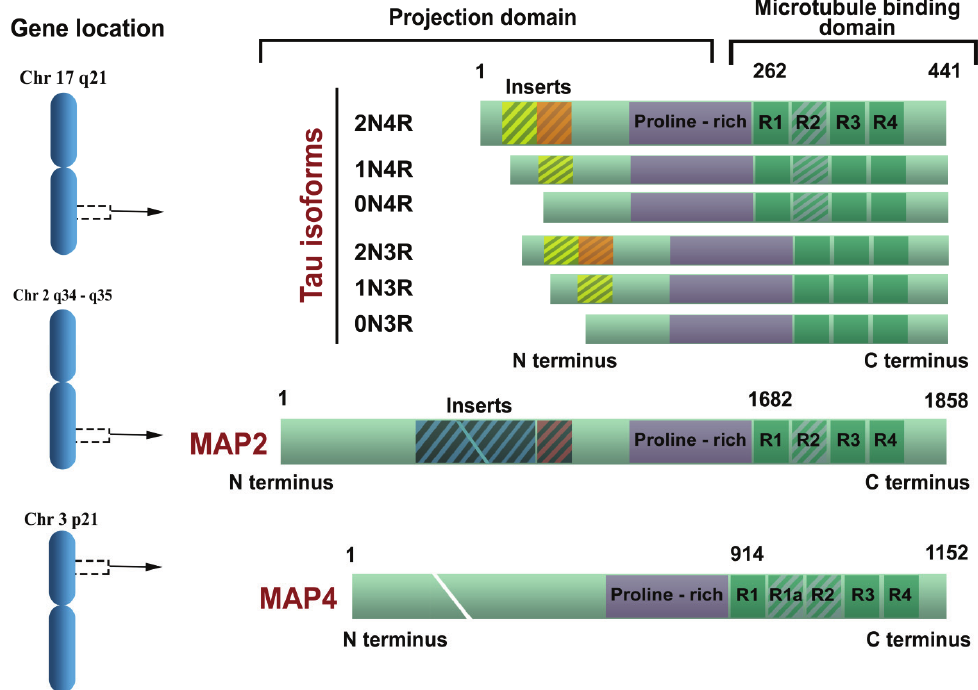
Figure 1. Chromosomal location of the gene and protein structure for the microtubule-associated proteins tau, microtubule-associated protein 2 (MAP2) and MAP4. Tau exons 2, 3 and 10 are alternatively spliced, giving rise to six different mRNAs, translated in six different tau isoforms. Tau isoforms differ by the absence or presence of one or two 29 amino acid inserts encoded by exon 2 (yellow) and 3 (orange) in the N-terminal part, in combination with either three (R1, R3 and R4) or four (R1-R4) repeat regions in the C-terminal part. The R2 repeat is encoded by exon 10. The longest 2N4R adult tau isoform (2+3+10+) has 441 amino acids (aa), followed by 1N4R isoform of 412 aa (2+3 ´ 10+), 2N3R isoform of 410 aa (2+3+10 ´ ), 0N4R isoform of 383 aa (2 ´ 3 ´ 10+), 2N3R isoform of 381aa (2+3 ´ 10 ´ ) and the shortest 0N3R isoform of 352 aa (2 ´ 3 ´ 10 ´ ). The single neuron-specific promoter of MAPT gene has three binding sites for transcription factors and its activity increases with axon initiation and outgrowth. The shortest tau isoform is the only one expressed in the fetal brain (“fetal tau”), while expression of other isoforms begins postnatally (for a review, see [48]). The MAP2 and MAP4 have comparable repeat domain sequences in the C-terminus but differ from tau proteins by their longer N-terminal projection